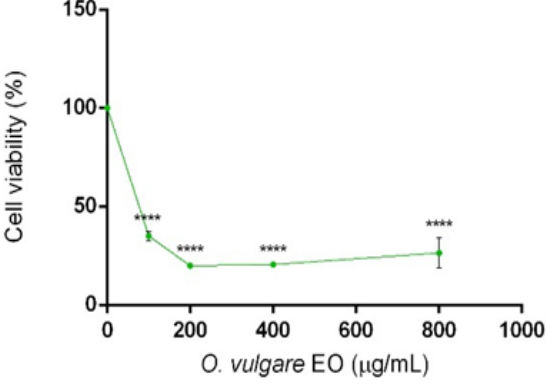
Figure 1. Percentage of cell viability after 3-(4,5-dimethylthiazol-2-yl)-2,5-diphenyl tetrazolium bromide (MTT) assay. Cells were treated with different doses (800–100 µg/mL) of Origanum vulgare EO for 24 h and solvent (DMSO, 0.1%) alone. Data are the mean ± SD of three experiments **** - p < 0.0001.